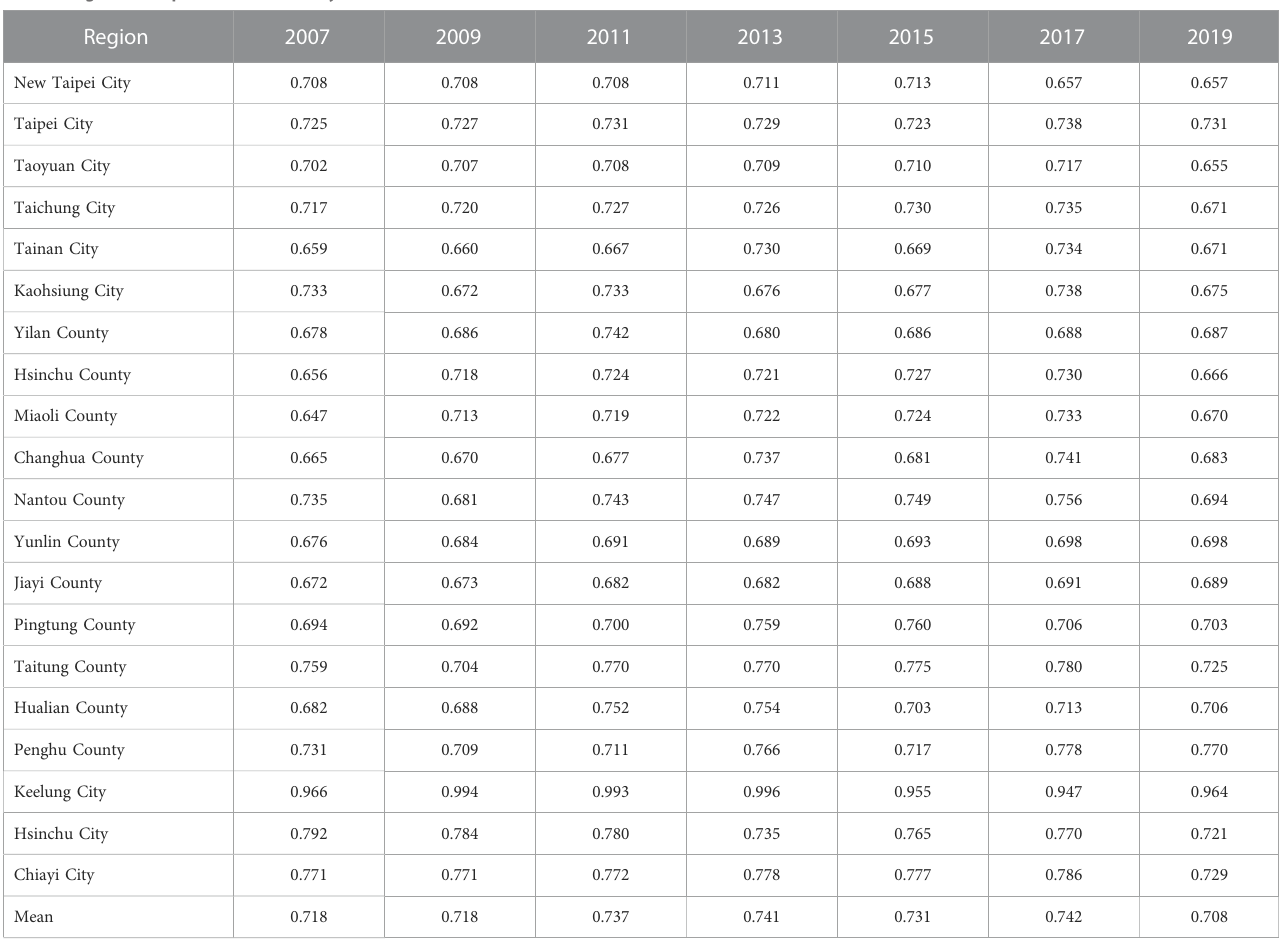
TABLE 1 Agricultural production ef fi